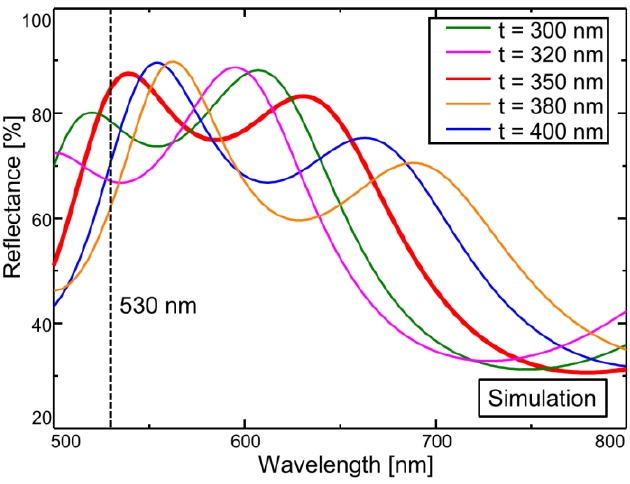
Figure 3. Reflectance spectrum of the Fabry–Perot interferometer for different thicknesses of the parylene-C film. The optical multilayer films are designed to use a 350-nm-thick parylene-C film and 400-nm-thick silicon-dioxide film with an air gap of 300